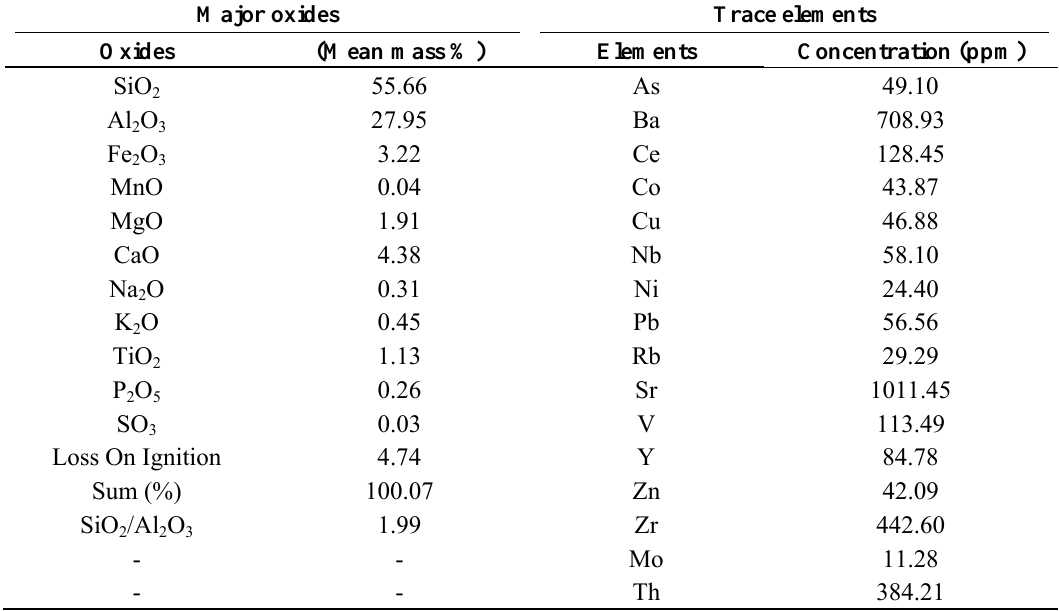
Table 1. Chemical composition of the South African fly ash used in this study.